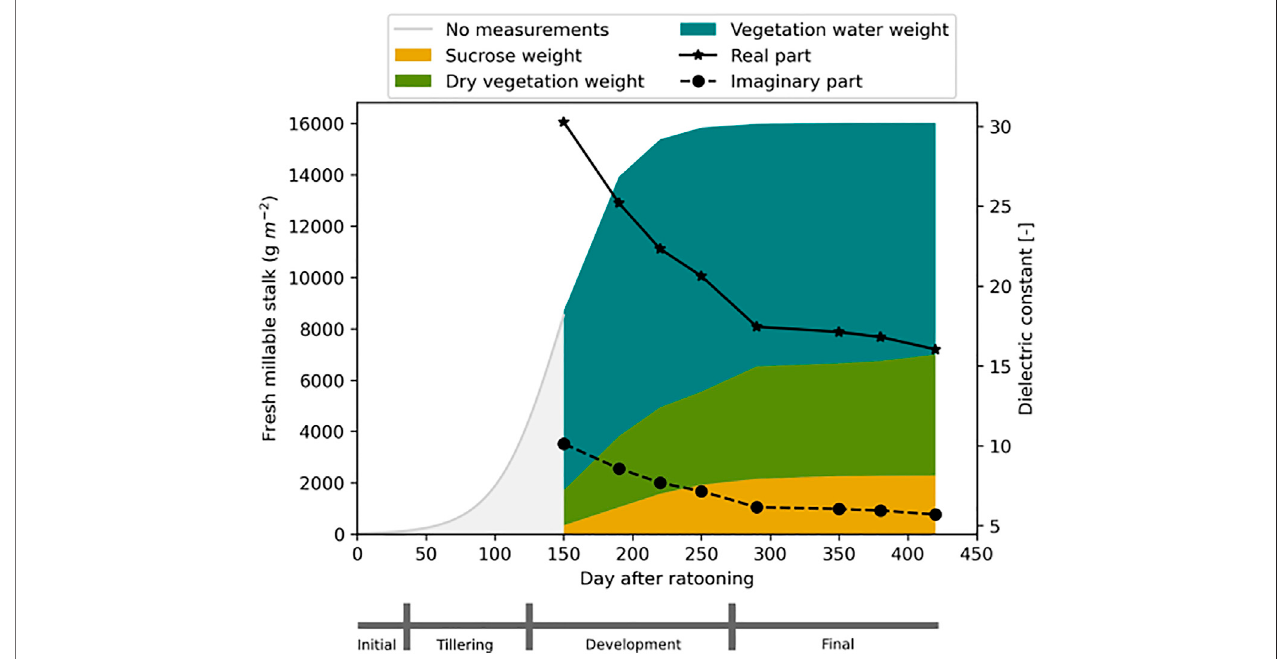
FIGURE 4 | Results of a fi eld campaign by Muchow et al. (1996) and the in fl uence of the change in distribution between bound and free particles on the dielectric properties of vegetation. The bar below the fi gure indicates the length of the different crop stages.